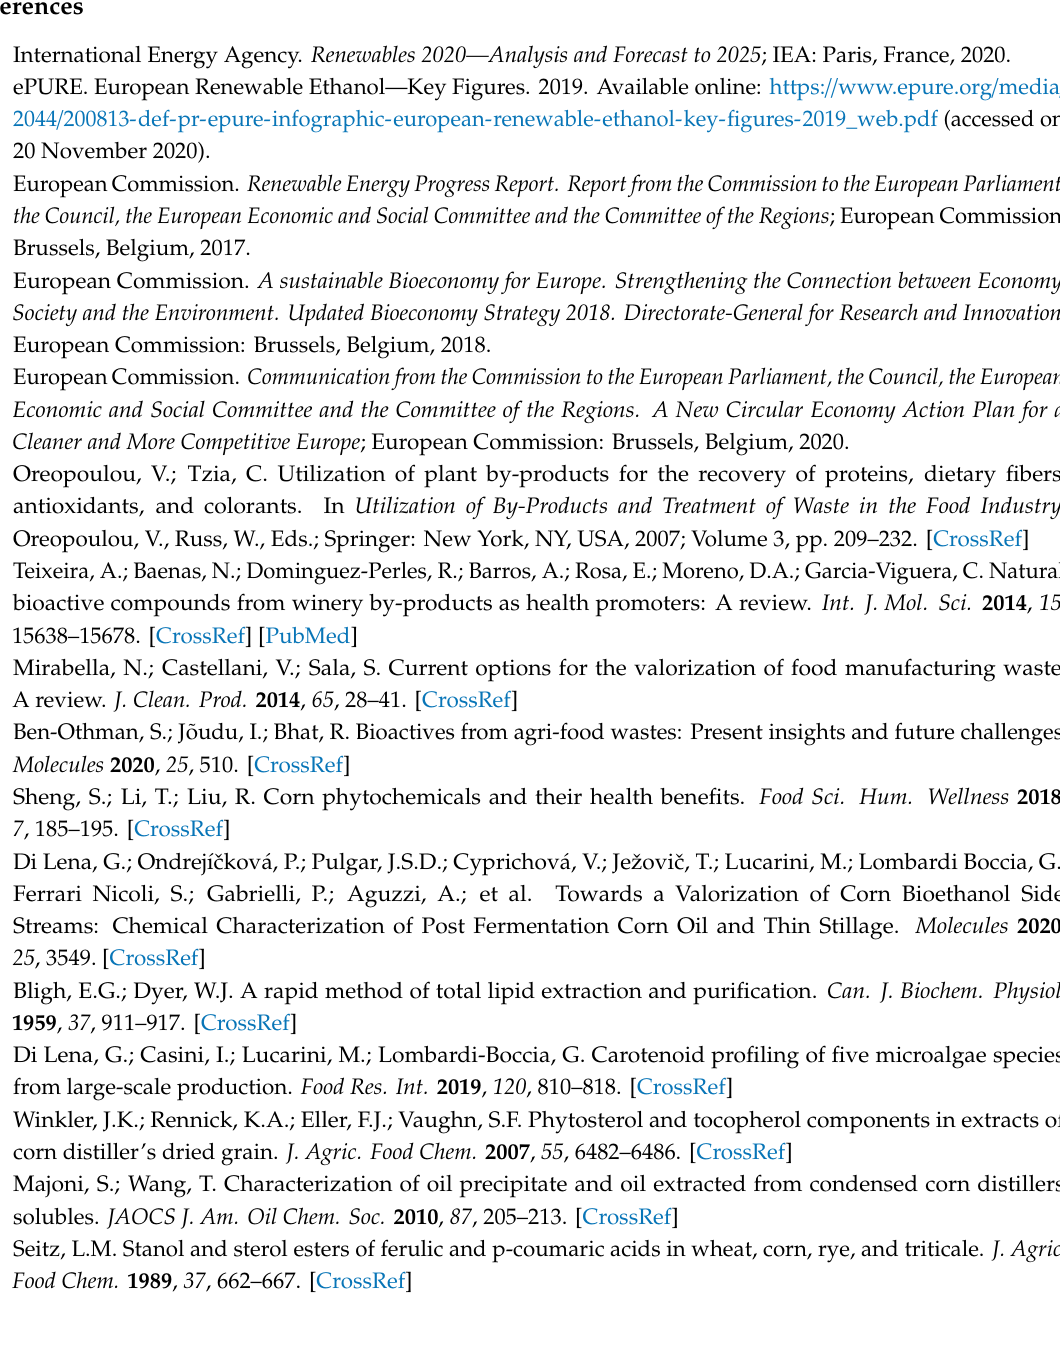
Figure S1: Relative distribution of phytosterols in post-fermentation corn oil and thin stillage from a dry-grind corn ethanol plant. Figure S2: Relative distribution of tocopherols (T) and tocotrienols (T3) in post-fermentation corn oil and thin stillage from a dry-grind corn ethanol